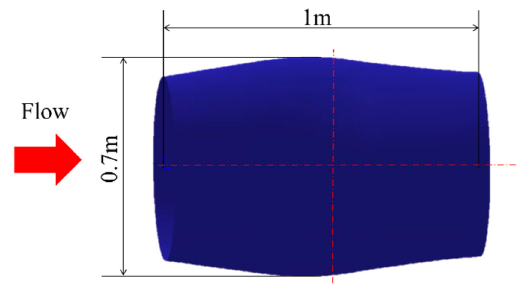
Figure 2. Experimental model.